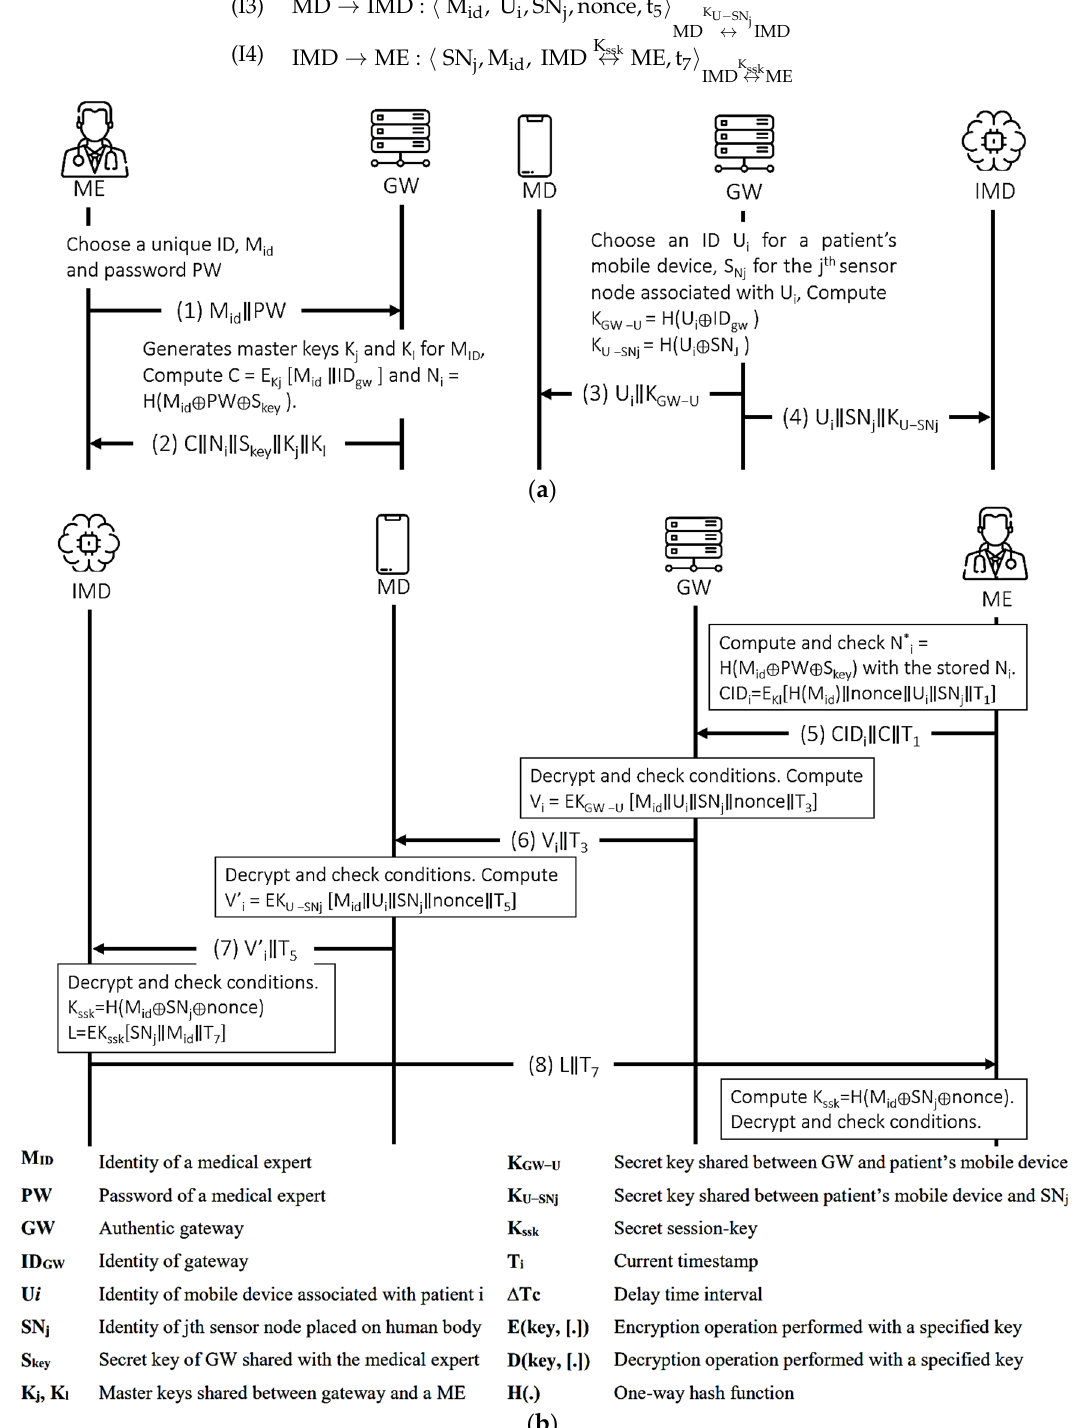
Figure 10. Parvez et al.’s protocol. ( a ) Registration procedure. ( b ) Authentication Procedure.